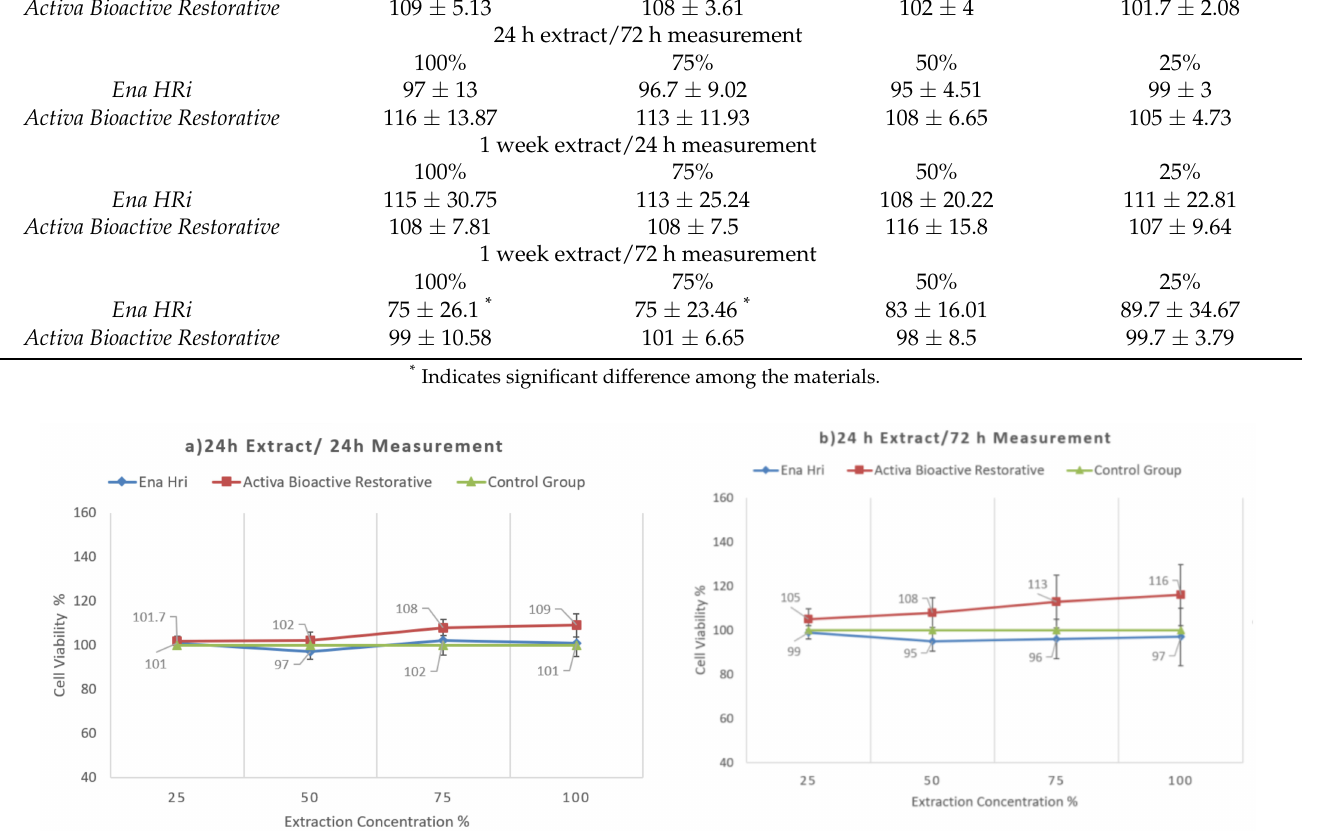
Figure 6. The viability of cells exposed to 24 h extracts of Activa Bioactive Restorative and Ena HRi at ( a ) 24 h and ( b ) 72